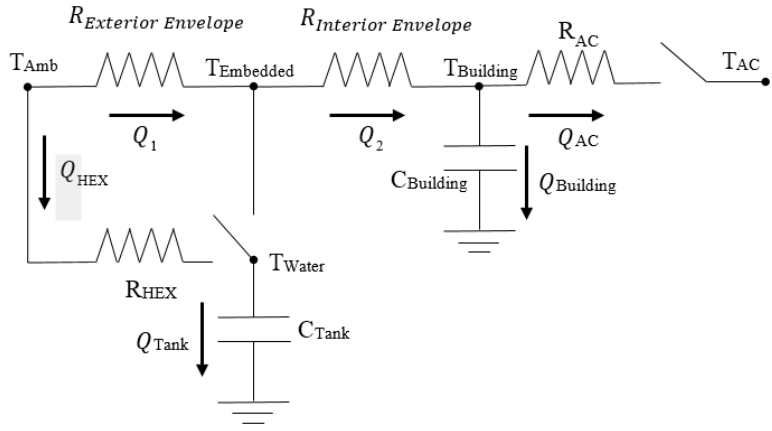
Figure 3. ITC/TSM building